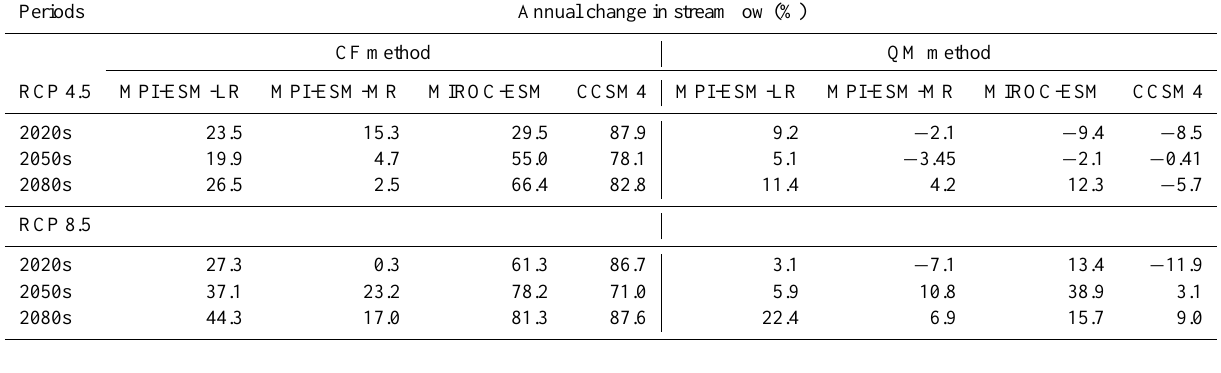
Table 8. Possible annual streamflow changes in the future years (2020s, 2050s and 2080s) of the DRB. Periods